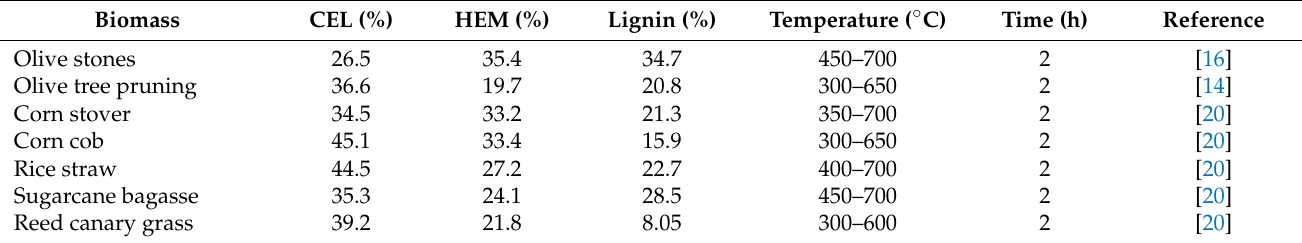
Table 1. Fiber composition on a dry basis and pyrolysis conditions of biomasses used for bio-oil production. Biomass CEL (%) HEM (%) Lignin (%) Temperature ( ◦ C) Time (h) Reference Olive stones Olive tree pruning Corn stover Corn cob Rice straw Sugarcane bagasse Reed canary